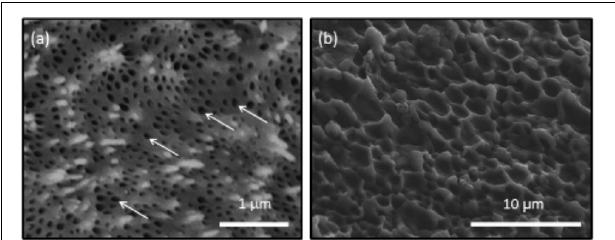
FIGURE 4 | Scanning electron microscopy observations of the surface of the growing edge of the ligament (a) after decalcification using 1 M CH 3 COOH and (b) after treatment with hrMMP-13. The decalcified treatment showed many holes on the surface of the ligament. Treatment of hrMMP-13 degraded the microstructure of the ligament. White arrows indicate the